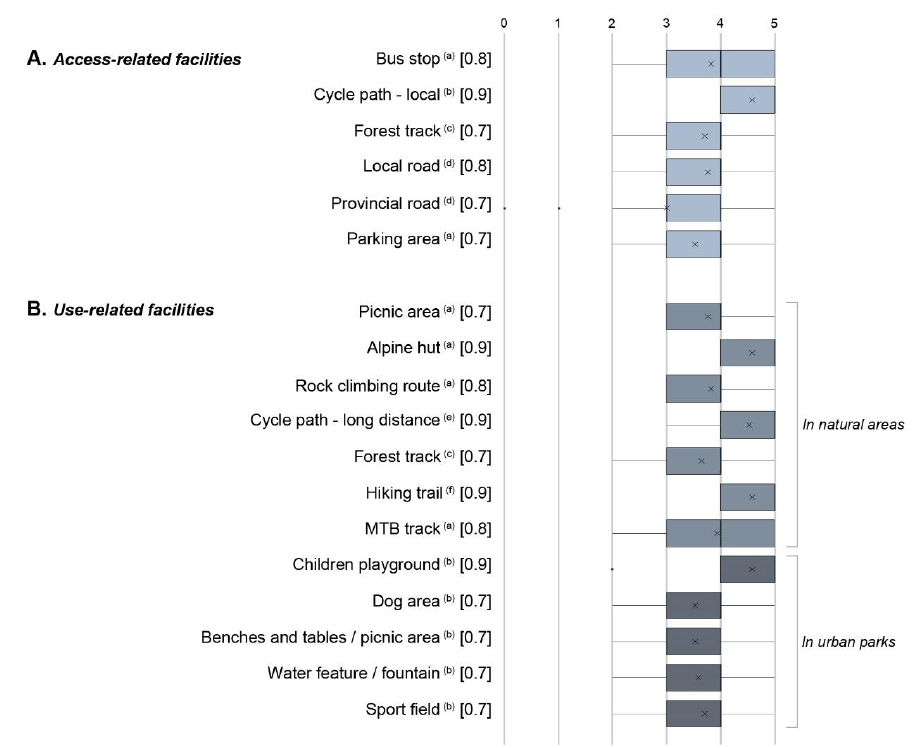
Figure 5. Box-plots showing the distribution of the scores assigned to access-related and use-related facilities and infrastructures by local experts. In square brackets are the final normalized scores used to run the model. Colors identify main categories of data. Data sources: (a) [53]; (b) [59]; (c) [60]; (d) [61]; (e) [62]; and (f) [63].